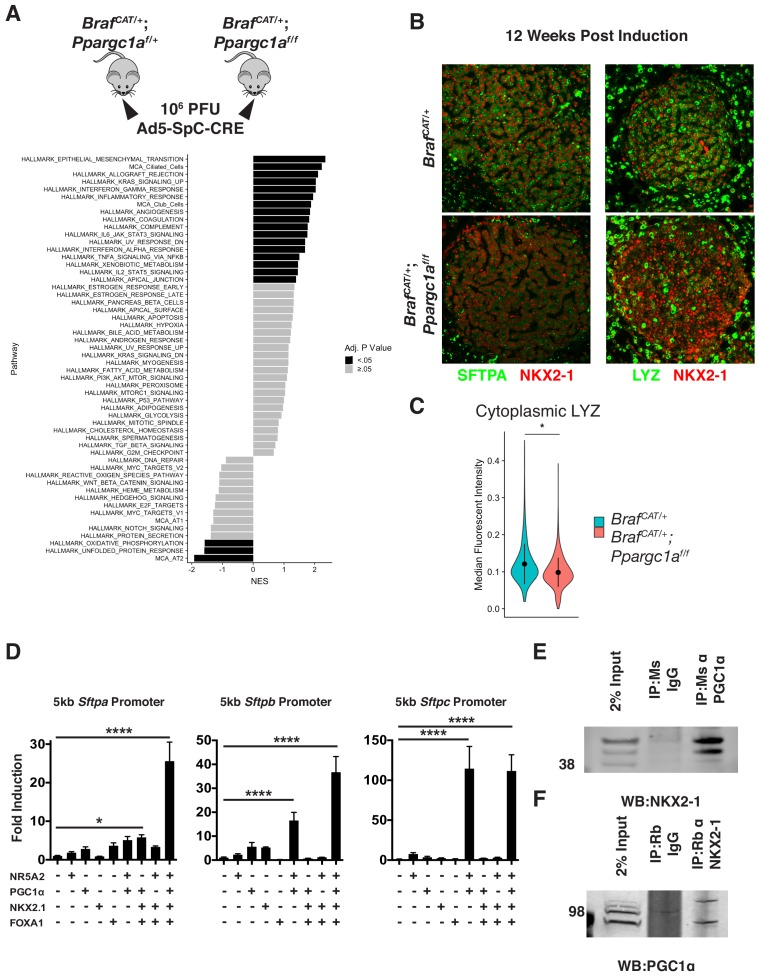
PGC1α is required for maintenance of lung identity in BRAFV600E driven tumors.(A) Tumors were induced in cohorts of BrafCAT/+ and BrafCAT/+;Ppargc1af/f mice via intranasal instillation of 106 PFU Ad5-SpC-CRE and harvested from each genotype 12 weeks post tumor induction via tissue dissociation and FACS. GSEA analyses of hallmark pathways and lung identity gene sets. Black bars indicate adjP <.05, gray bars indicate Benjamini-Hochberg corrected enrichment statistic adjP ≥. 05. (B) Immunostaining confirms decreased expression of the AT2 markers SFTPA and LYZ in BRAFV600E/PGC1αNULL tumors. (C) Quantitation demonstrating a significant decrease of LYZ immunoreactivity in BRAFV600E/PGC1αNULL tumors. Wilcoxon rank sum p val. = 0.0288. (D) Luciferase assays in HEK293T cells demonstrating the cooperation of NKX2-1, FOXA1, PGC1α, and NR5A2 in transactivation of surfactant promoters. All three promoters showed significant induction by ordinary one-way ANOVA (p<0.0001). Comparison of individual groups to mock transfected controls by Dunnett’s test for multiple comparisons: (*) p=0.0189, (****) p<0.0001. (E) Co-Immunoprecipitation of NKX2-1 by immunoprecipitation with a mouse monoclonal antibody recognizing PGC1α but not with IgG. (F) Co-Immunoprecipitation of PGC1α by immunoprecipitation with a mouse monoclonal antibody recognizing NKX2-1 but not with mouse IgG.10.7554/eLife.43668.038Figure 7—source code 1.R script to perform gene set enrichment analysis on Figure 7—source data 1, as well as plot these results.10.7554/eLife.43668.039Figure 7—source code 2.R script to perform statistics on Figure 7—source data 2, as well as plot these results eLife’s transparent reporting form.10.7554/eLife.43668.040Figure 7—source data 1.DEseq2 output of differentially expressed genes comparing BRAFV600E/PGC1αNULL and BRAFV600E/PGC1αHET driven tumors.10.7554/eLife.43668.041Figure 7—source data 2.Cellprofiler output quantifying immunofluorescence of LYZ in BRAFV600E/PGC1αNULL and BRAFV600E/PGC1αWT driven tumors.10.7554/eLife.43668.042Figure 7—source data 3.Data from luciferase assays looking for transactivation of Sftpa, Sftpb, and Sftpc promoters.